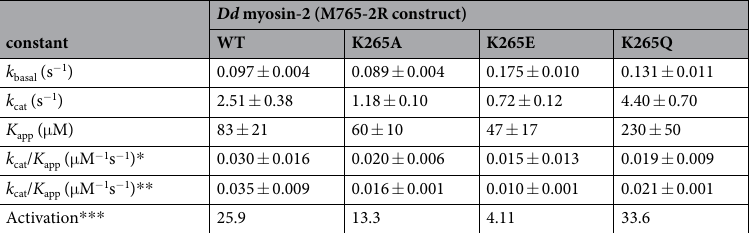
Table 1. Summary of the steady state ATPase parameters for myosin-2 WT and mutant constructs. Experimental conditions: 25 mM HEPES, 25 mM KCl, 5 mM MgCl 2 , 1 mM DTT, 1 mM ATP, pH 7.3; T = 25 °C. * calculated from k cat and K app . ** slope of the first four values of actin-activated ATPase measurements. *** calculated as k cat / k basal